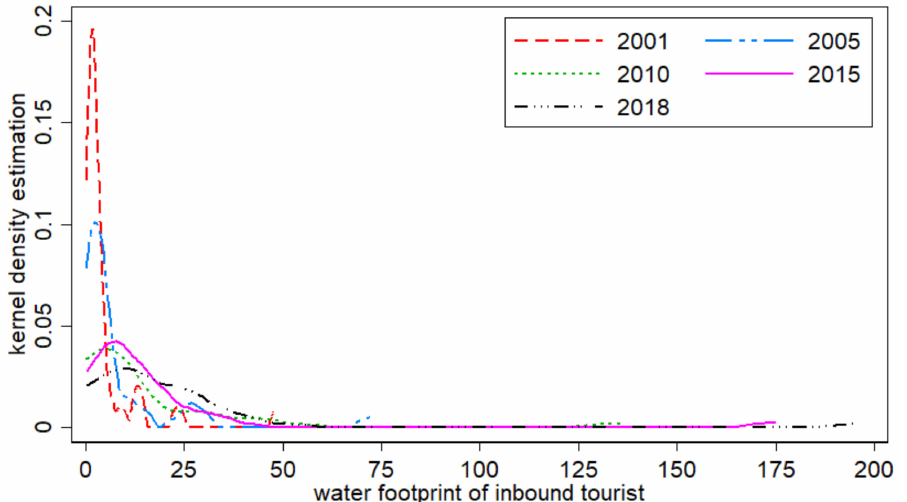
Figure 2. The dynamic evolution of the water footprint of inbound tourists to China from 2001 to